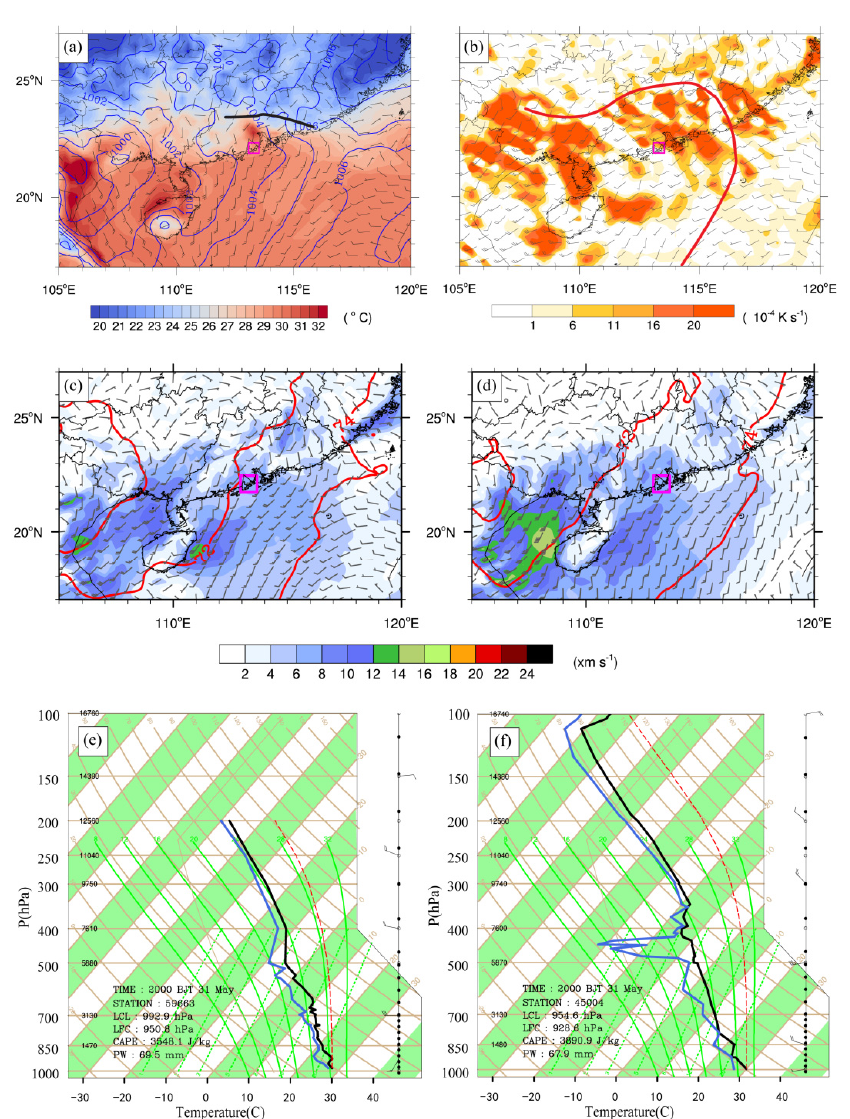
Figure 3. Weather background at 2000 LST on 31 May 2021 ( a – c , e , f ), 0200 LST on 01 June 2021 ( d ): ( a ) Surface pressure field (contour), air temperature (color; unit: °C), and surface horizontal wind. The solid black line represents the position of the front; ( b ) 850 hPa temperature advection (color; unit:10 − 4 K s − 1 ), 850 hPa horizontal wind, and pseudo-equivalent potential temperature line of 350 K (red thick solid line; ( c , d ) 925 hPa horizontal wind (color; unit: m s − 1 ), and height field (contour); ( e )The skew T ‐ LogP diagram of Yangjiang (dew point curve in blue, temperature cure in black and parcel trajectory in red); ( f ) Skew T ‐ LogP chart of Hong Kong. Purple box indicates location of rainfall of interest.